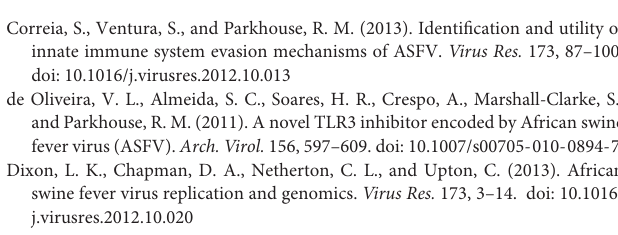
TABLE S5 | The IFN levels in serum after the